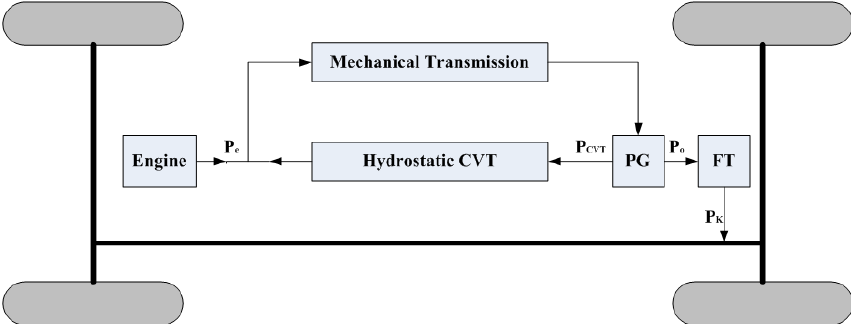
Figure 5. Hydrostatic CVT, backward power recirculation.